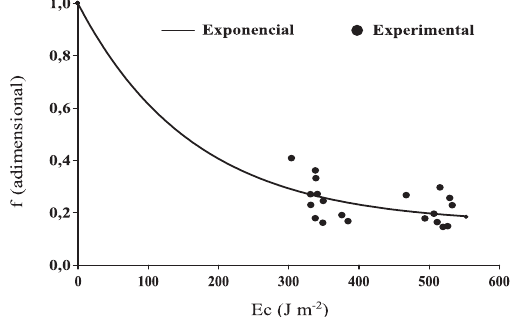
figura 6. valores do decaimento da tie ( f ) em função da energia cinética acumulada da chuva